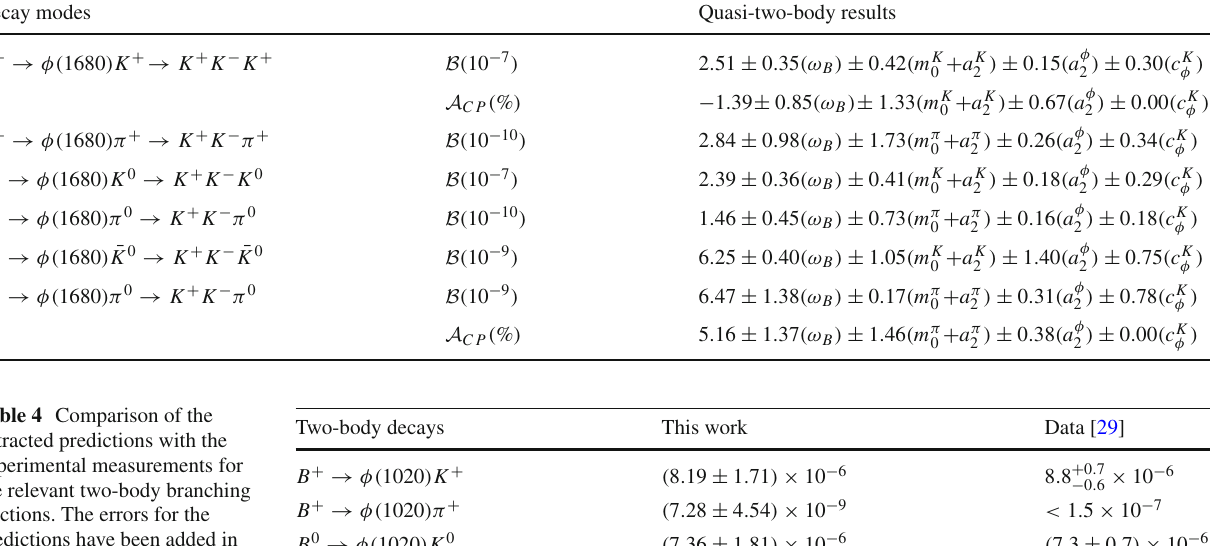
Table 3 PQCD predictions of the CP averaged branching fractions and the direct CP asymmetries for the B → φ( 1680 ) h → K + K − h Decay modes